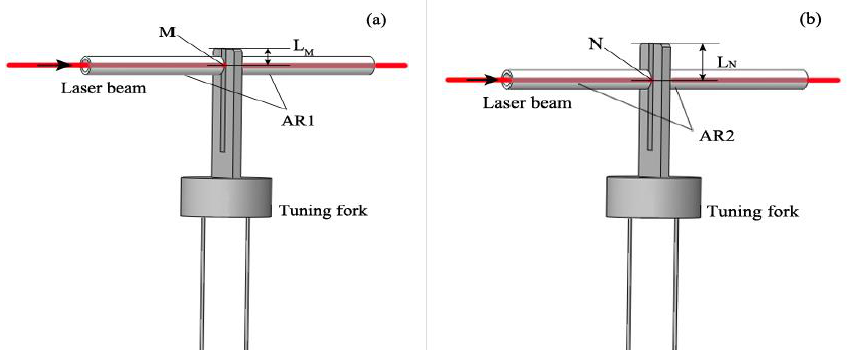
Figure 2. Two ARs work separately; ( a ) the case where only AR1 is used; ( b ) the case where only AR2 is used.